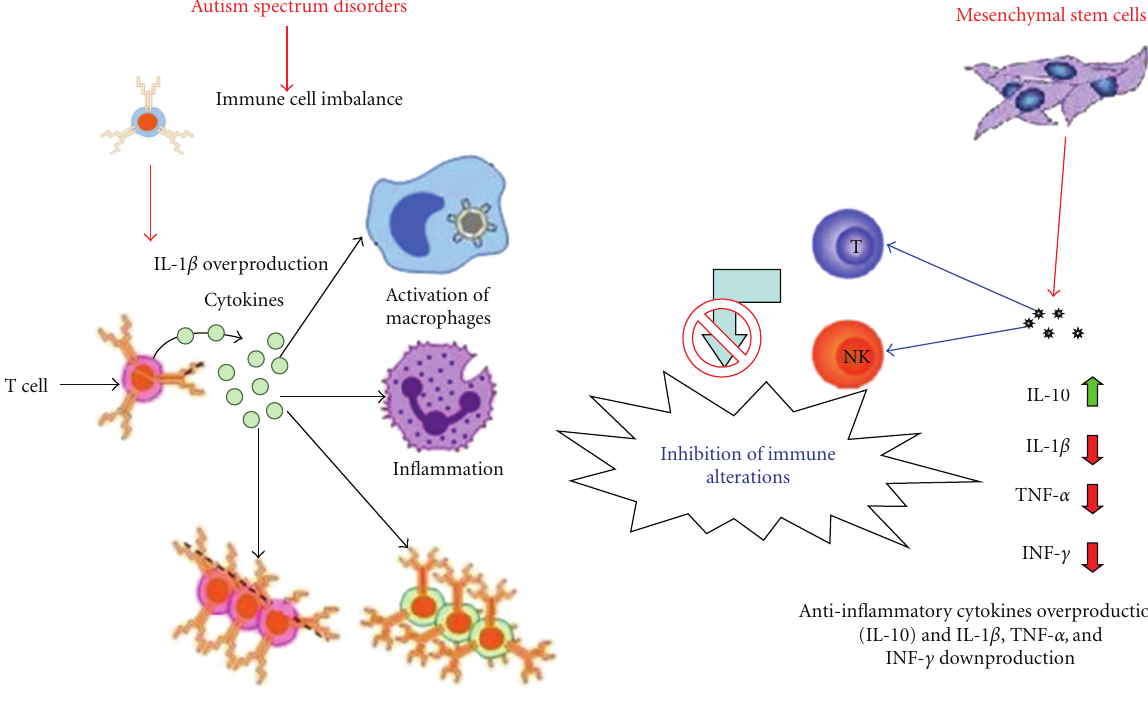
Figure 1: Paracrine and immunomodulatory e ff ects as possible mechanisms of action of mesenchymal stem cells (MSCs) in autism spectrum disorder (ASD) treatment. In humans, ASDs are associated with immune alterations and pro-inflammatory cytokines (i.e., IL-1 β ) over- production. These cytokines are able to trigger pro-inflammatory cellular events. Data from in vitro models show that MSCs are able to a ff ect not only T cells, but also other cells of the immune system (i.e., NK cells). Immunoregulatory properties of MSCs are through secretion of large amounts of several bioactive molecules (paracrine activity), that is, PGE-2, IL-10. These molecules cause the inhibition or the unresponsiveness of T-cell mediated